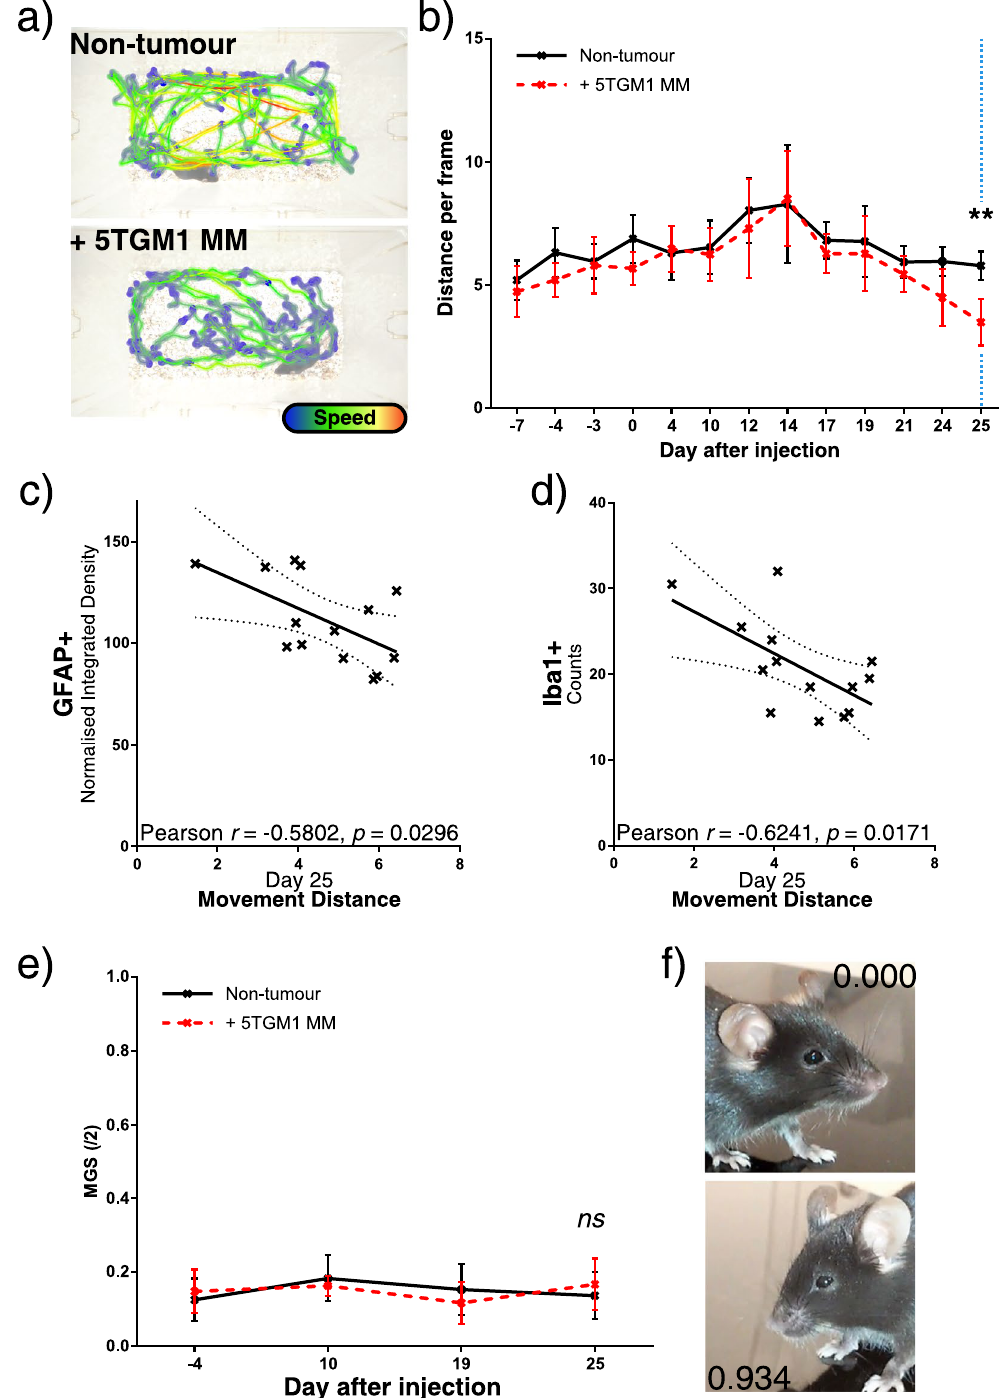
Figure 3. Mouse movement is reduced with tumour burden, and correlates to spinal glial activation. ( a ) Representative mouse path traces 25 days after tumour or control inoculation, with colour indicating relative instantaneous mouse speed, and ( b ) average locomotion in two-minute videos taken across the experiment. Statistical comparison by two-way ANOVA with Sidak’s multiple comparisons test. ( c ) Correlation between day 25 locomotion data and GFAP + or ( d ) Iba1 + quantification from previous figure. Pearson’s r correlation coefficient and p value shown. ( e ) Mouse grimace scores (MGS) out of a maximum of two. Mouse faces were photographed repeatedly at each time point and randomised, then scored by two blinded trained observers, and resulting scores averaged. Mean MGS is shown for each treatment group. Statistical comparison by two-way ANOVA with Sidak’s multiple comparisons test. ( f ) Average scores for an example control (MGS: 0.000/2.000) and moderate (MGS: 0.934/2.000) grimace image. All statistical comparisons: ns : not significant, * p < 0.05; ** p < 0.01; *** p <